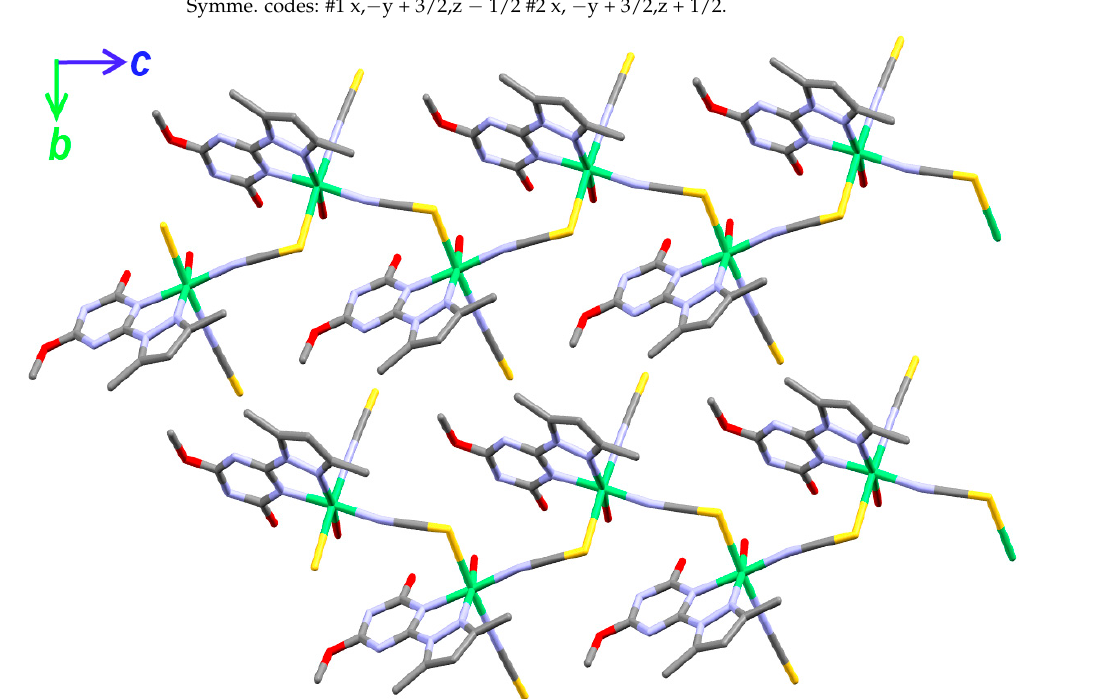
Figure 3. The packing scheme of the 1D polymeric structure of the [Ni(MPT)(H 2 O)(SCN) 2 ] n complex. All H-atoms were omitted for better clarity.